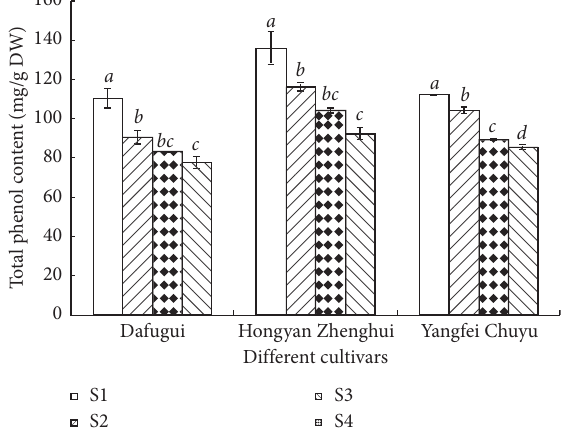
Figure 7: Total flavonoid content of developmental P. lactiflora petals (mg/g DW). Different letters within each cultivar indicated significant differences at 5%